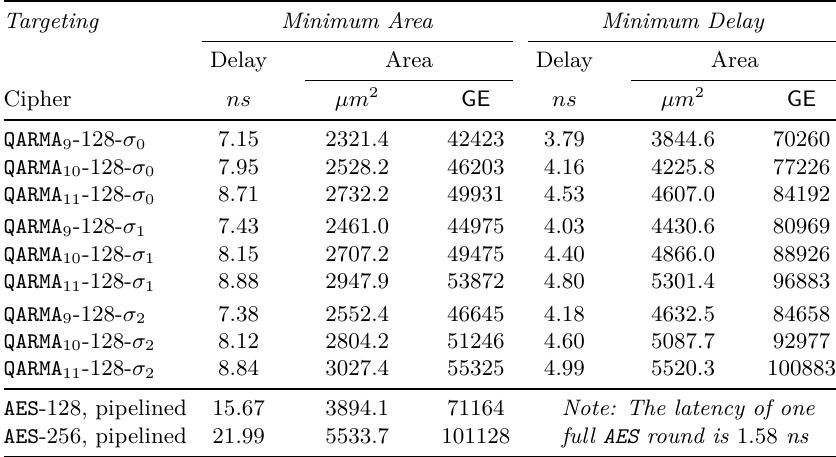
Table 9: Delay and Area for QARMA -128 (fully unrolled), and the AES (pipelined) Targeting Minimum Area Minimum Delay Delay Area Delay Area Cipher